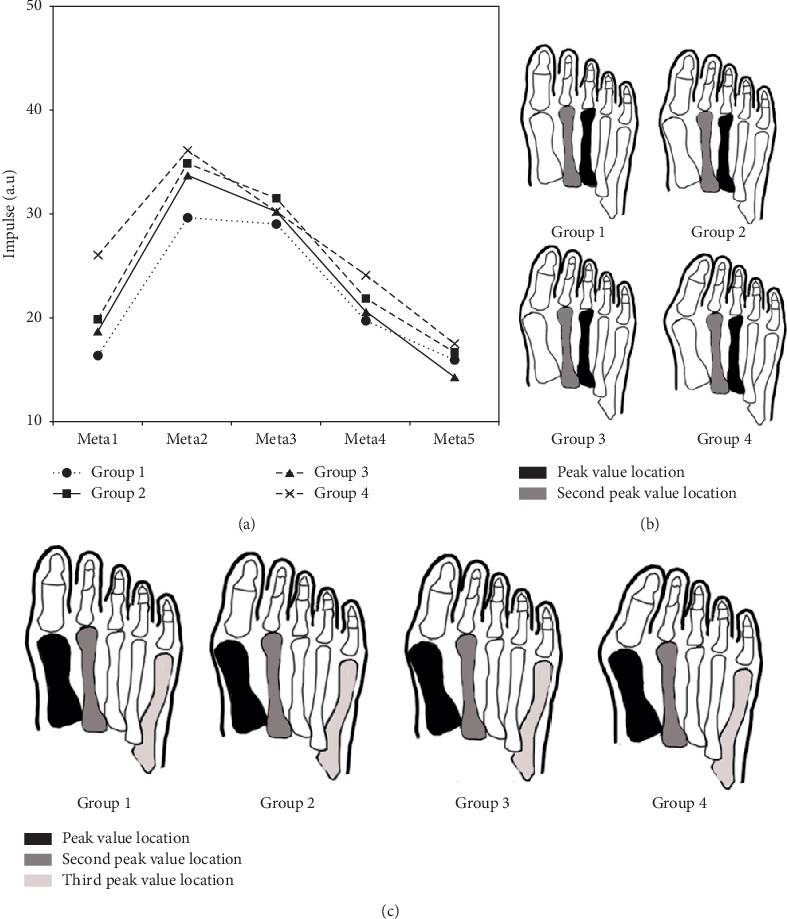
Five metatarsal regions in four groups (a) Impulse (It represents that the process of mutation is from the metatarsal contact ground to return its original state); (b) contact duration; and (c) contact area.